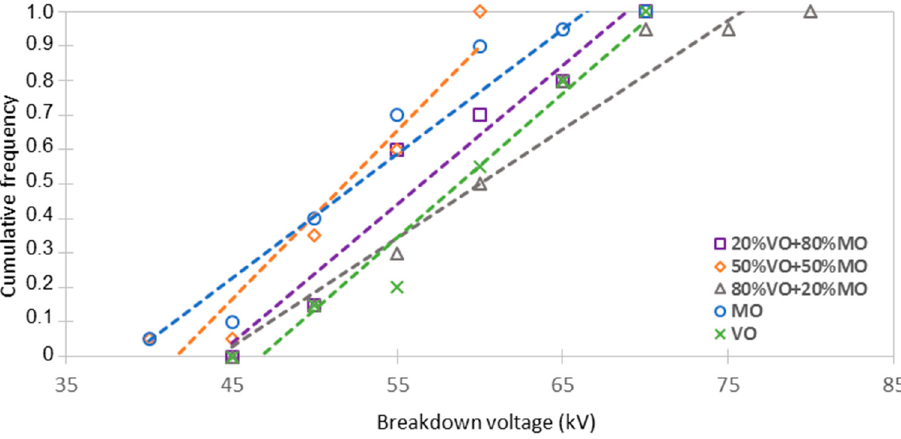
Figure 12. Linear trend of the cumulative frequency of DC breakdown voltage of mineral oil and natural ester mixtures.